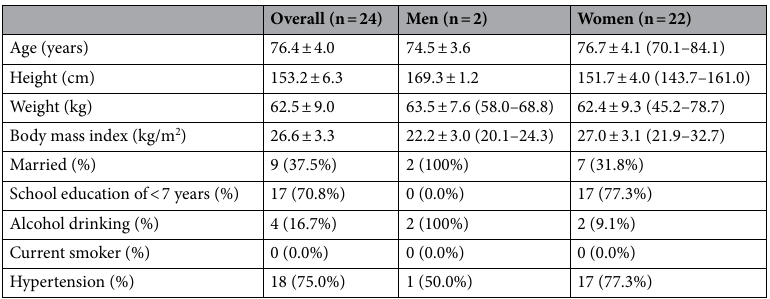
Table 1. Characteristics of the study participants who underwent total knee replacement surgeries. Values are presented as means ± standard deviations (range) or numbers (%).